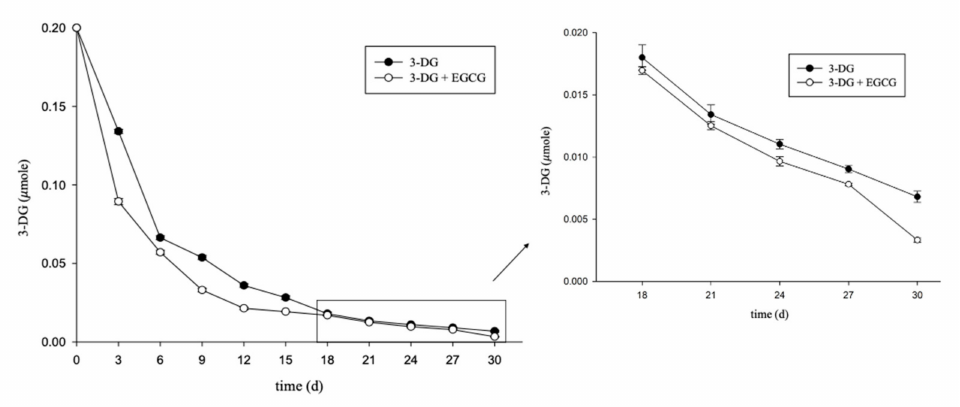
Figure 3. Kinetics curves of 3-DG in the 3-DG or 3-DG + EGCG model heated at 70 ◦ C for 30 days.